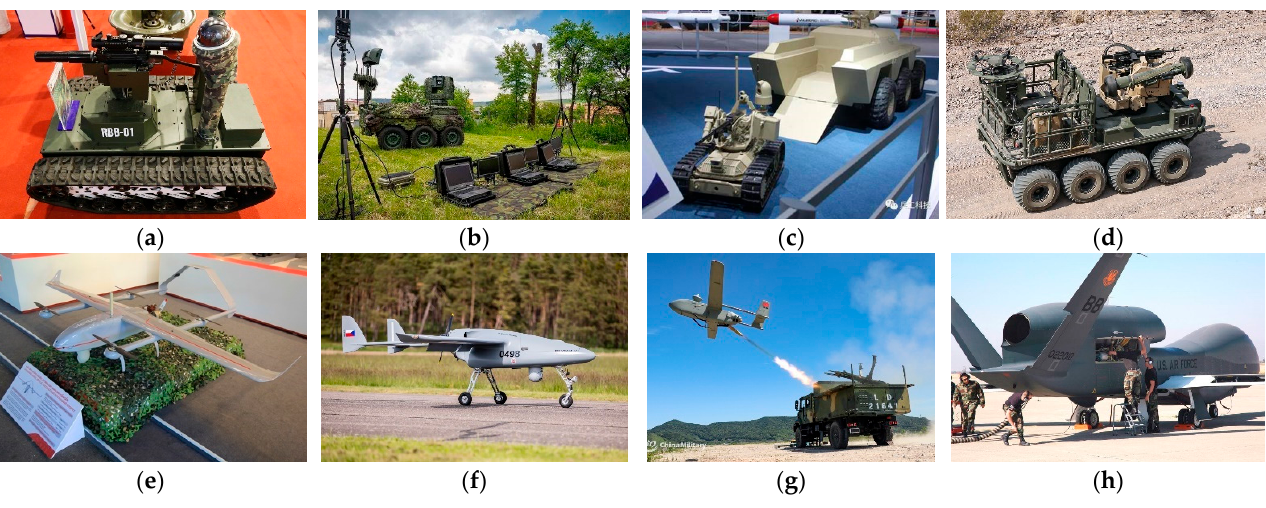
Table 1. NATO UAS Classification Guide [10,19,20].